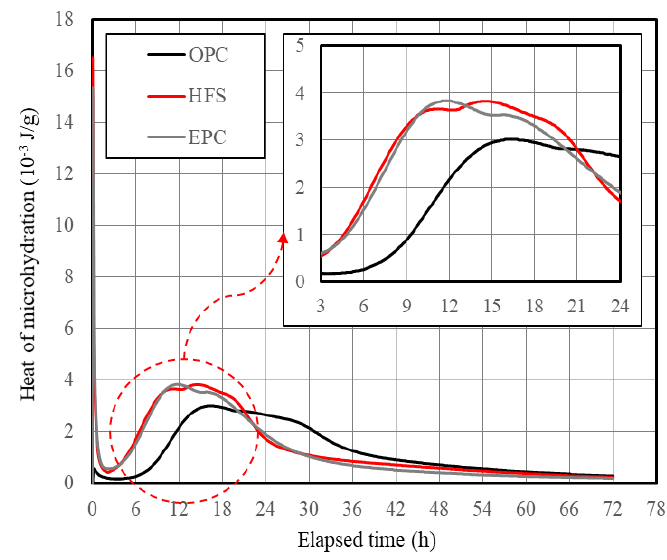
Figure 7. Heat of microhydration according to elapsed time for each cement type.